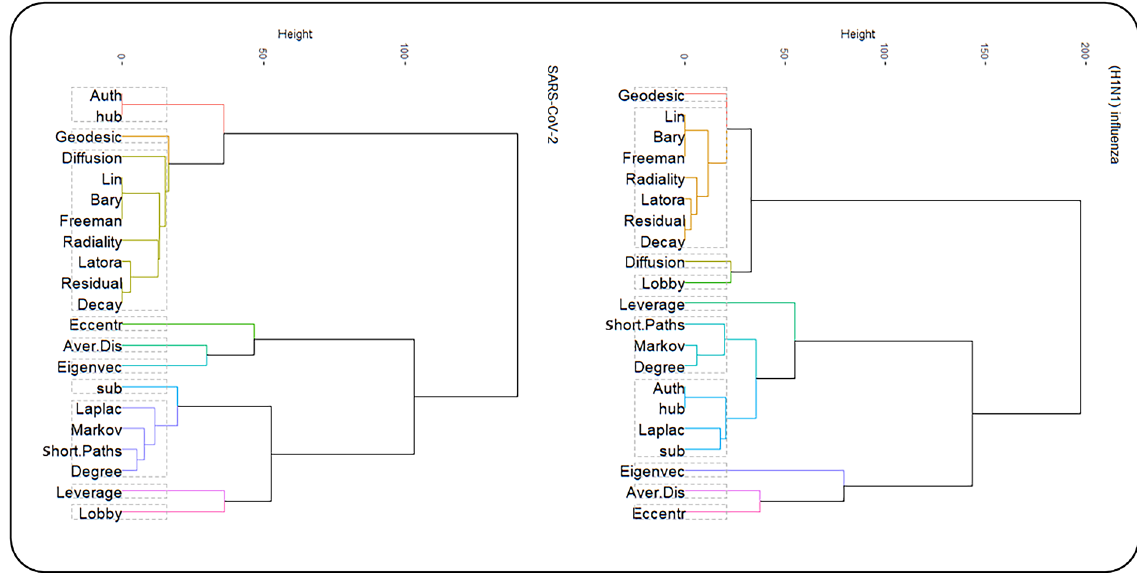
Figure 8. Clustering dendrograms for SARS-CoV-2 and (H1N1) influenza